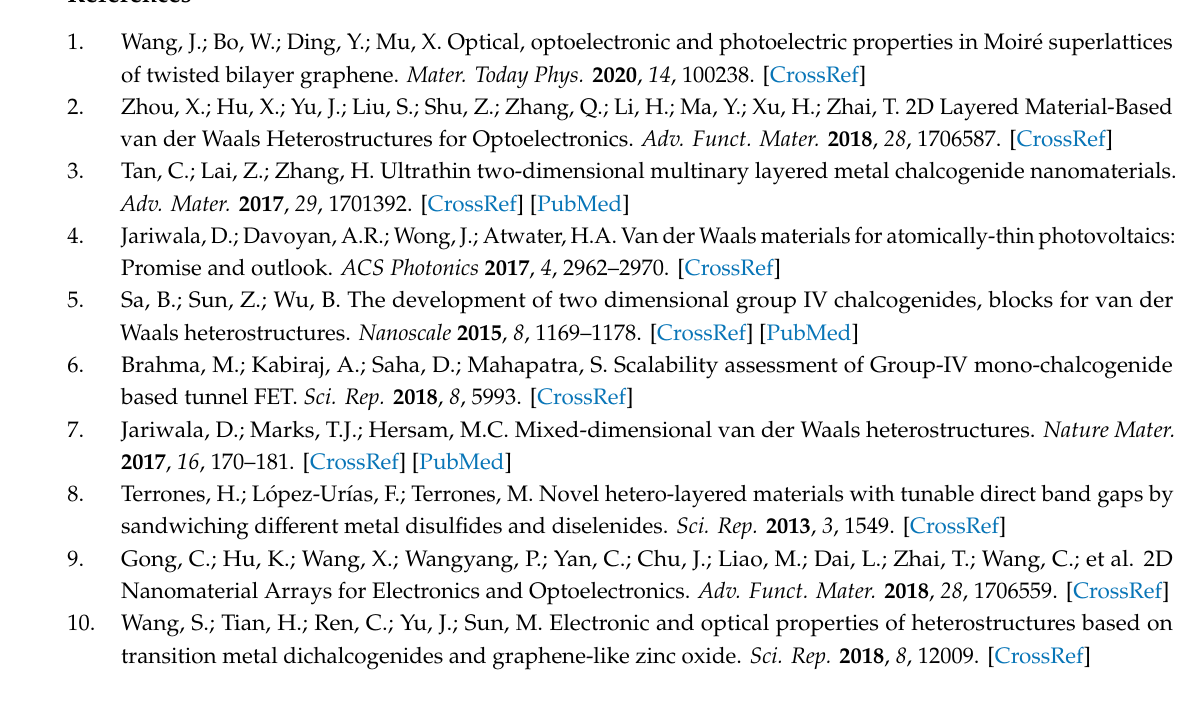
Figure S1: Band structures of bulk GaX (a) and InX (b) (X = S, Se, Te) calculated using WC-GGA with (green curves) and without polarization (black curves), mBJ (red curves) and optB88-vdW (blue curves) functionals. Figure S2: (a) Electron density and (b) Laplacian distributions of bulk, mono-, bi, and trilayered GaS in the ( − 110) plane. Labels “ b ”, “ r ” and “ c ” represent bond, ring and cage critical points at the zero-flux surface, respectively. Figure S3: Polynomial fitting h | BD | M–X + l | BD | M–M + m | BD | X–X vs. ε 1 (0) as the equation order goes from the first to second and to the third: Coe ffi cient of determination R 2 of (a) bulk, (b) bilayer, and (c) trilayer, by adjusting h / m and l / m ratios and their respective maximum R 2 . Figure S4: (a) In-plane ( xx ) and out-of-plane ( zz ) refractive indexes, (b) absorption coe ffi cients and (c) loss tangents of N ◦ 1–9 GaX / InX. Figure S5: In-plane ( xx ) and out-of-plane ( zz ) absorption coe ffi cients of N ◦ 1–9 GaX / InX compared with those of their constitutive top and bottom bilayers (a–i). Figure S6: Electron density distributions of N ◦ 1–9 GaX / InX along the < 110 > plane (a–i). Labels “ b ”, “ r ” and “ c ” represent bond, ring and cage critical points at zero-flux surface, respectively. Figure S7: Laplacian of electron density distributions of N ◦ 1–9 GaX / InX along the < 110 > plane (a–i). Labels “b”, “r” and “c” represent bond, ring and cage critical points at the zero-flux surface, respectively. Figure S8: Bond angle (BAs) of (a) In–In, (b) In–X, (c) Ga–Ga and (d_)Ga–X bonds of N ◦ 1–9 GaX / InX (red color), and the constitutive top [GaX] 2 (blue color) and bottom [InX] 2 (black